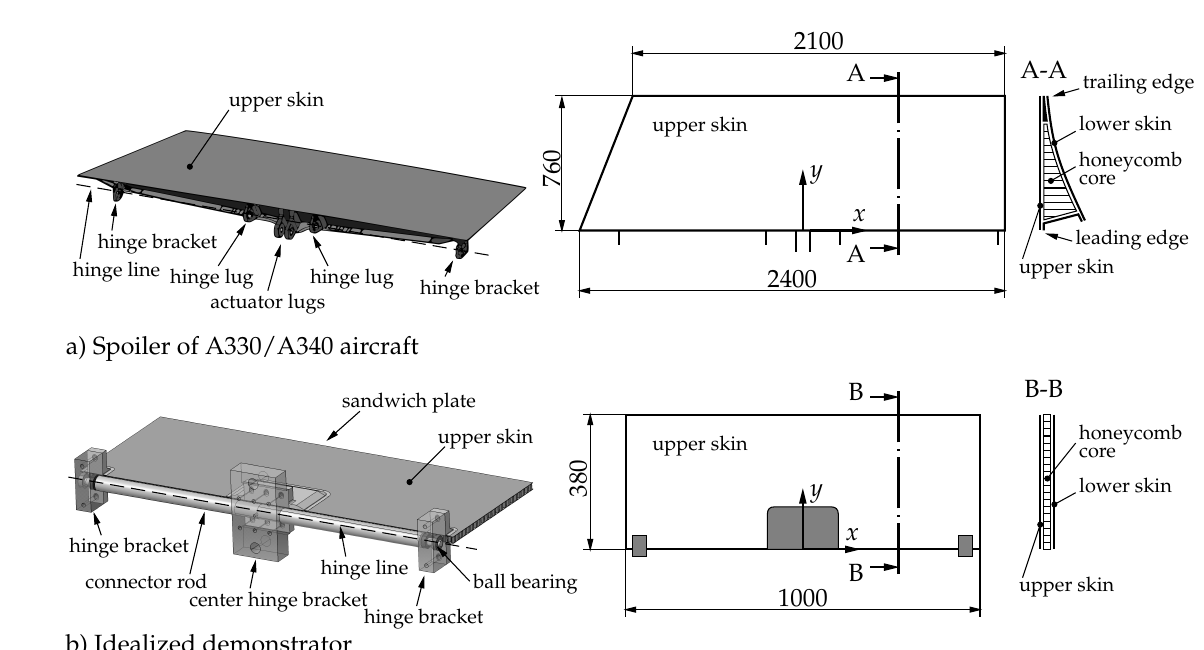
Figure 2. Shape and dimensions of ( a ) the real aircraft spoiler considered in comparison to ( b ) the developed idealized spoiler